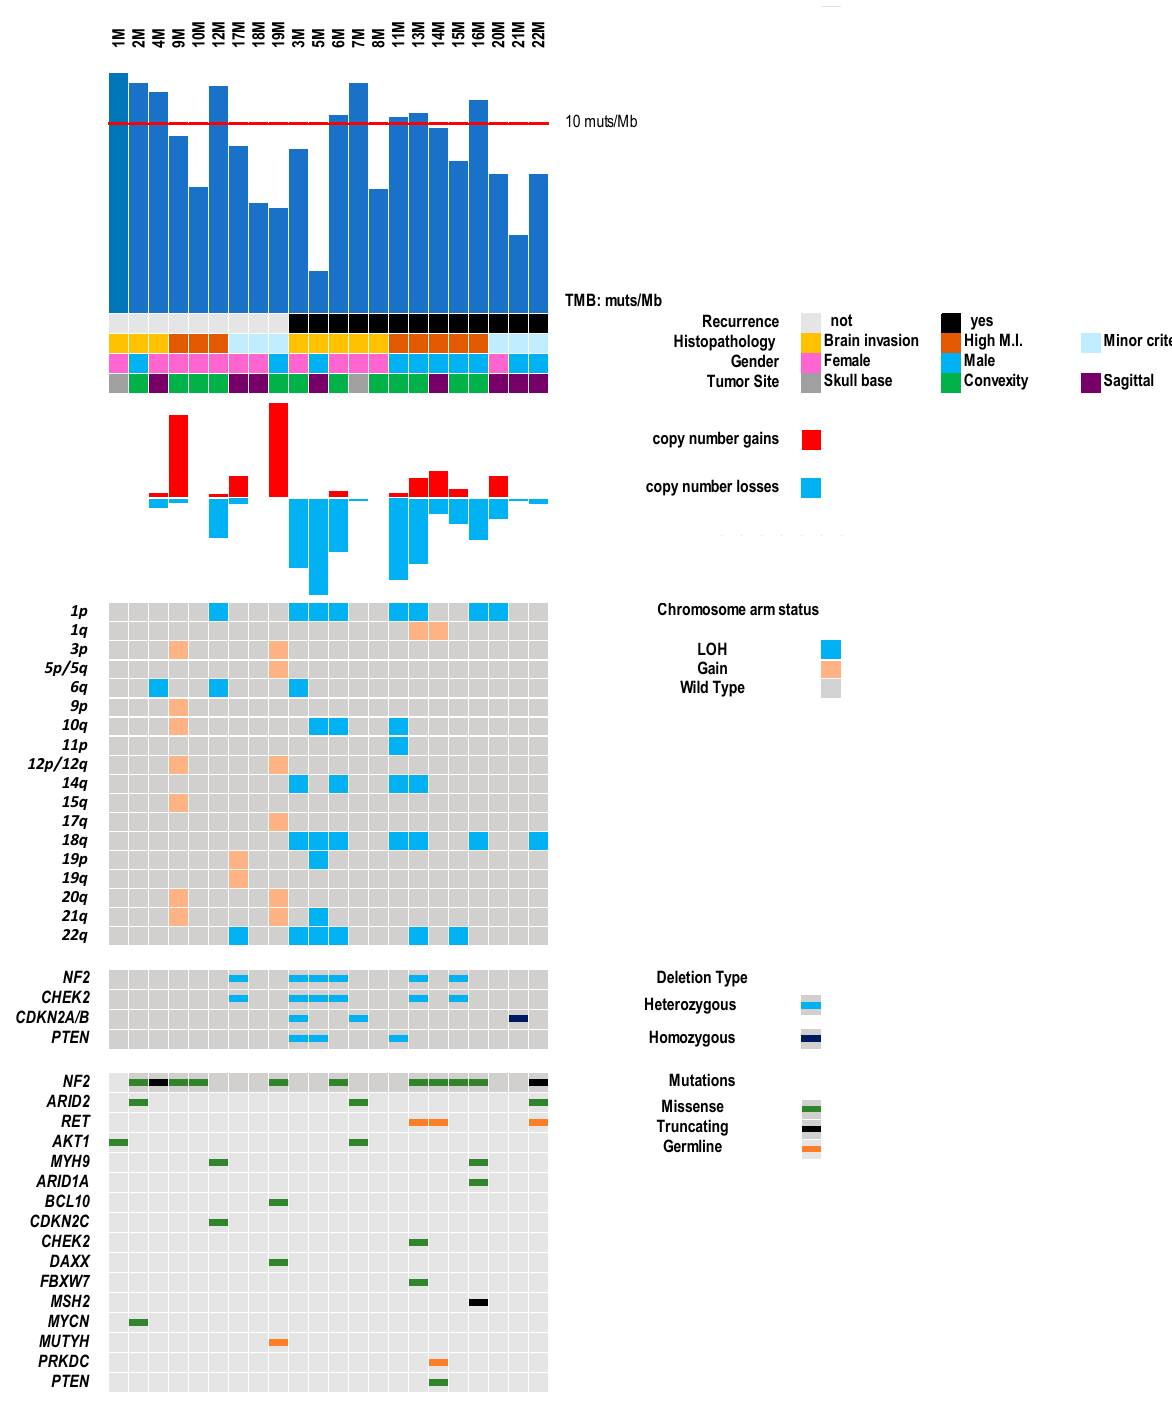
Figure 1. Genomic landscape of 22 atypical meningiomas. The matrix shows 18 genes that were altered at sequencing analy- sis, and the main chromosomal alterations. Samples are ordered according to the presence of recurrence and meningioma histopathological